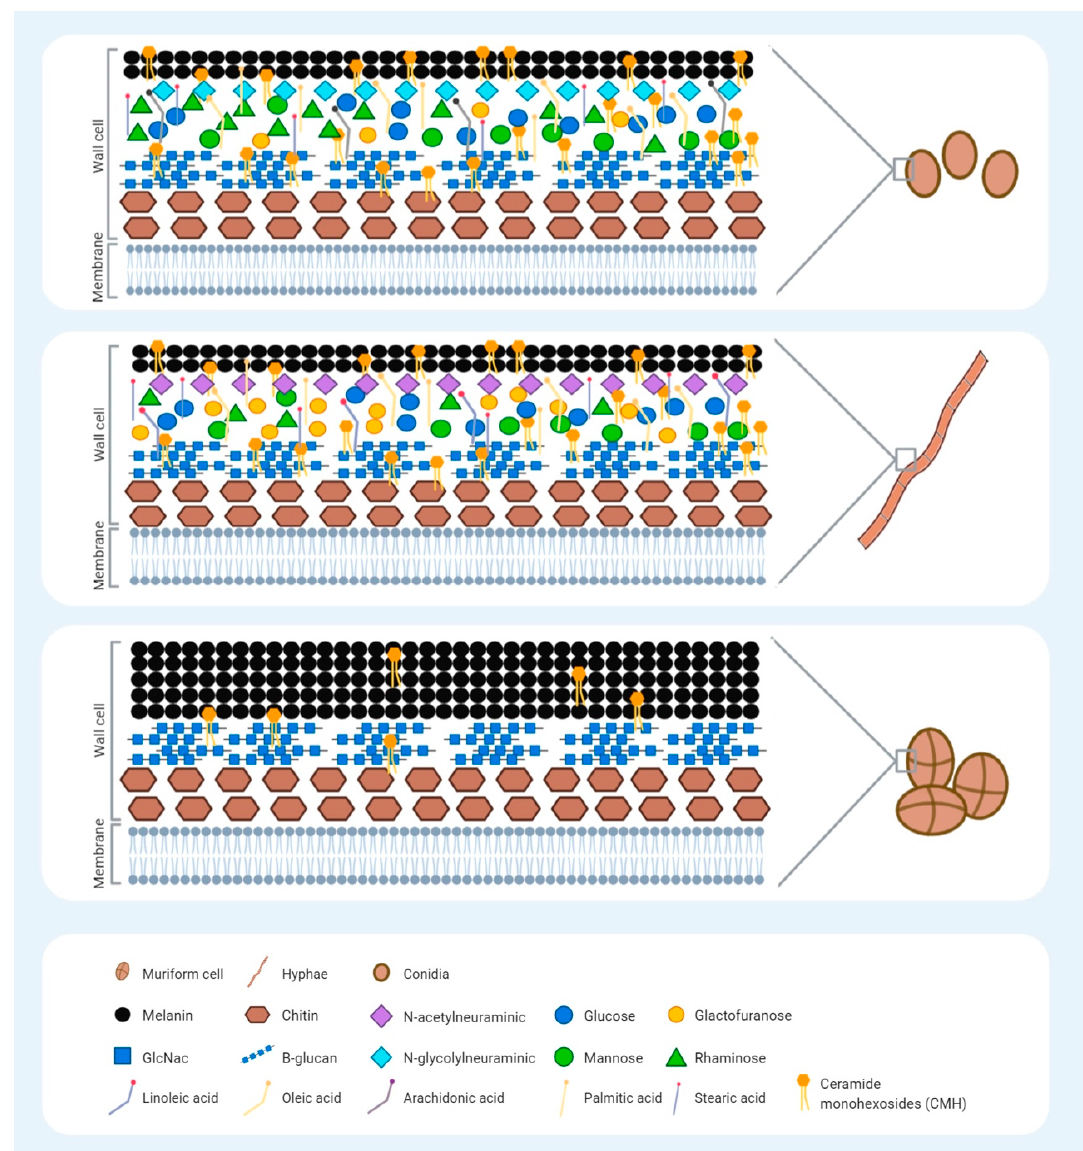
Figure 1. Schematic representation of the Fonsecaea pedrosoi cell wall, highlighting the reported molecules in each morphological form: conidia, hyphae, and muriform cells. The fungal cell wall is a heterogenic structure that is important for activation of the host innate immune system during infection through the pathogen-associated molecular patterns (PAMPs) recognized by the Pattern-recognition receptors (PRRs) present on innate immune cells. The morphological forms of F. pedrosoi have similarities but also differences with regard to the type and amount of the molecules present. No difference in chitin and B-glucan expression have been reported for the three different forms of F. pedrosoi . Conidia predominantly express sialic acid N-glycolylneuraminicacid, whereas hyphae express N-acetylneuraminicacid. Carbohydrates, such as glucose, mannose, and glucosamine, are similarly deposited on conidia and hyphae surfaces; however, conidia have greater expression of rhamnosis, while hyphae have greater galactofuranosis expression. Conidia also present a greater amount of lipids than hyphae, and the expression of the arachidonic fatty acids seems to be exclusive to the conidia form. The expression of linoleic fatty acids is exclusive to the hyphae, while the palmitic, stearic, and oleic fatty acids are present in both morphologies. Ceramide monohexosides (CHM) consist of a carbohydrate unit bound to a ceramide with antigenic properties. Presenting on the surface of all three F. pedrosoi morphologies, it is related to fungal differentiation. Melanin is a pigment present in the outer layer of all forms of F. pedrosoi , which provides their typical dark brown or black stain. A higher deposition of melanin is observed in muriform cells that block the binding sites of the anti-CHM antibodies, contributing to a greater virulence and immune evasion in these